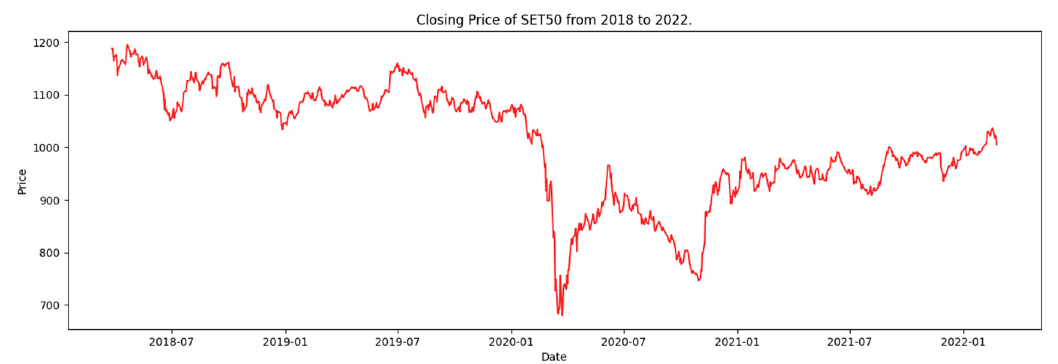
Figure 2. The daily closing price of the stock market in Thailand.